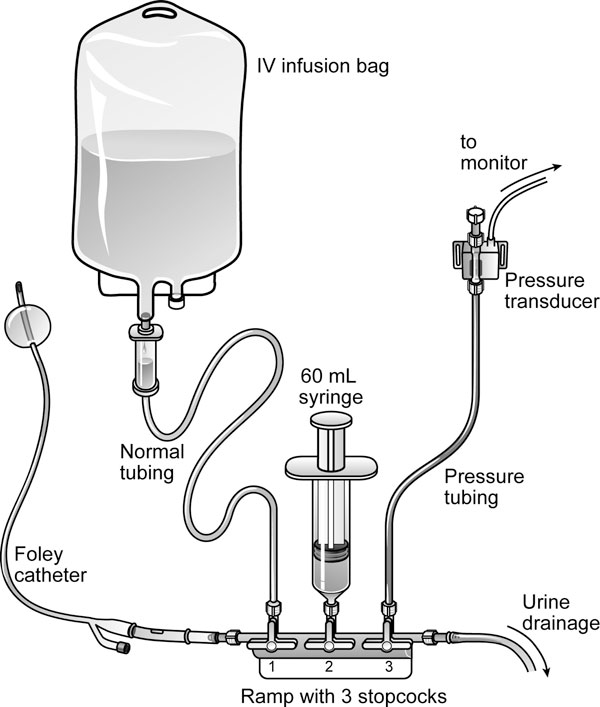
Modified method for intrabladder pressure monitoring as described by Malbrain (adapted from [3]with permission). Setup: - Using sterile scissors, the drainage tubing is cut 40 cm after the culture aspiration port after desinfection. - A ramp with three stopcocks is connected to a conical connection piece at each side with a male/male adaptor and inserted. - A standard intravenous (IV) infusion set is connected to a bag of 500 ml of saline and attached to the first stopcock. - A 60-ml syringe is connected to the second stopcock, and the third stopcock is connected to a pressure transducer via rigid pressure tubing. - The system is flushed with normal saline. Method of measurement: - Patient in supine position. - Zero pressure module at the midaxillary line at the level of the iliac crest (mark for future reference) by turning the proximal stopcock onto the air and the transducer. - At rest, the three stopcocks are turned 'off' to the IV bag, the syringe, and transducer giving an open way for urine to flow into the urometer - To measure IBP, the urinary drainage tubing is clamped distal to the ramp, and the third stopcock is turned 'on' to the transducer and the patient - The first stopcock is turned 'off' to the patient and 'on' to the IV infusion bag; the second stopcock is turned 'on' to the IV bag and the 60-ml syringe. - Aspirate 20-25 ml of saline from the IV bag into the syringe. - The first stopcock is turned 'on' to the patient, and the 20-25 ml of normal saline is instilled in the bladder - The first and second stopcocks are then turned 'on' to the patient and thus turned 'off' to IV tubing and the syringe. - The third stopcock already being turned 'on' to the transducer and patient allows then immediate IBP reading on the monitor.